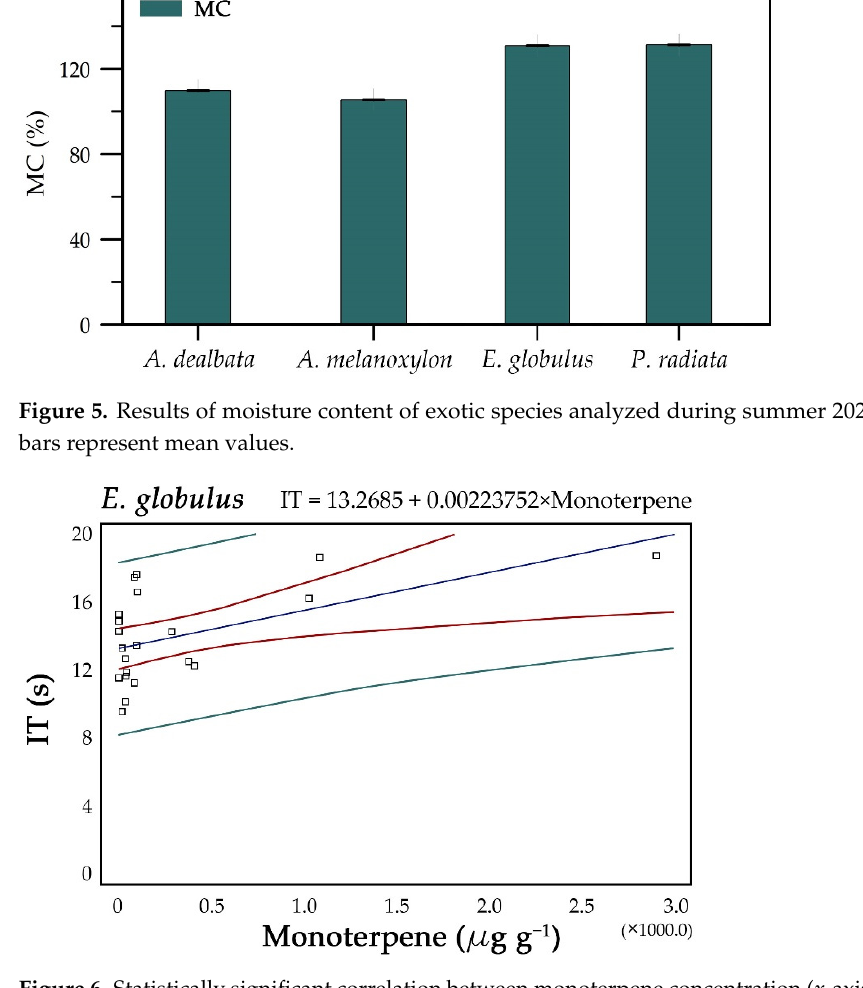
Figure 6. Statistically significant correlation between monoterpene concentration ( x -axis) and ignition time (IT, y -axis) of Eucalyptus globulus samples. Empty black squares represents data points, while blue strait line represents the least squares regression fit. Red lines (inner limits) represent the confidence interval, while green lines (external limits) represent the prediction limits, both at 95% confidence level.